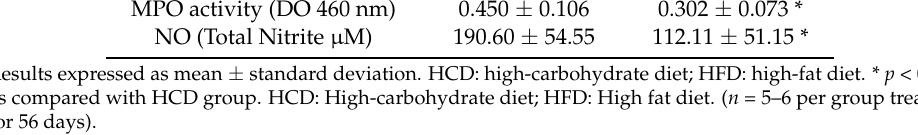
Table 5. Myeloperoxidase (MPO) activity and nitric oxide (NO) levels in the liver from mice fed either with high fat diet (HFD group) or with high carbohydrate diet (HCD group) for 56 days. HCD